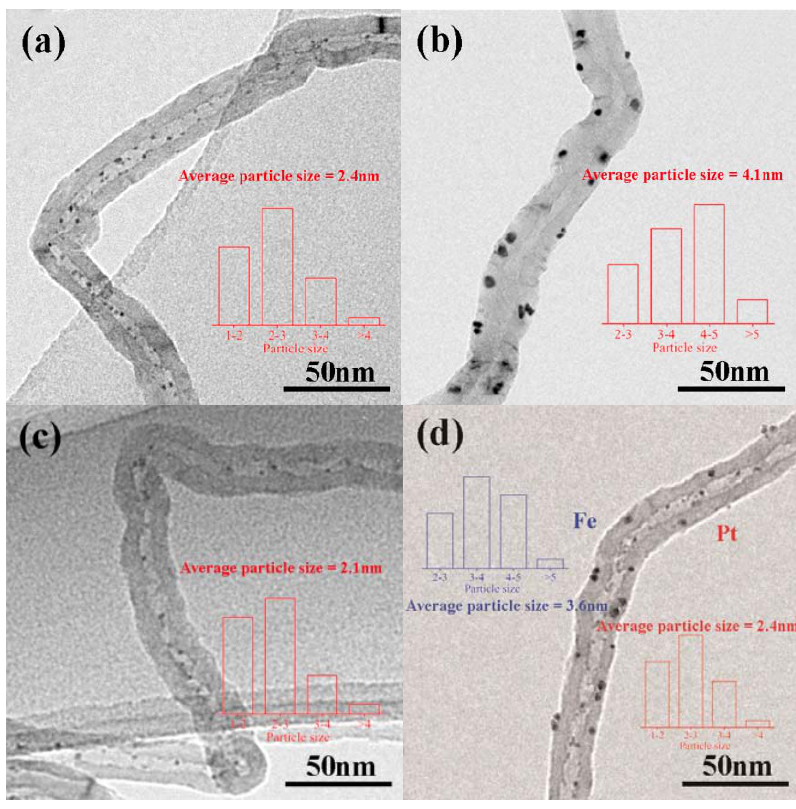
Figure 1. TEM images of ( a ) Pt–in/CNTs, ( b ) Pt–out/CNTs, ( c ) Pt–Fe(1.0)–in/CNTs, and ( d ) Pt–in–Fe–out/CNTs.